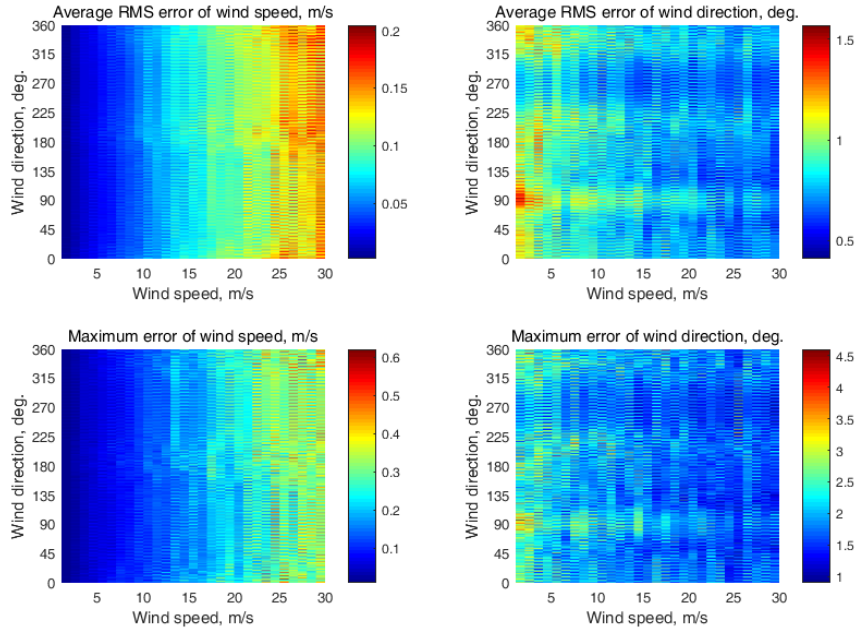
Figure A10. Semicircular wind retrieval results at the (35°, 40°) incidence angle combination.